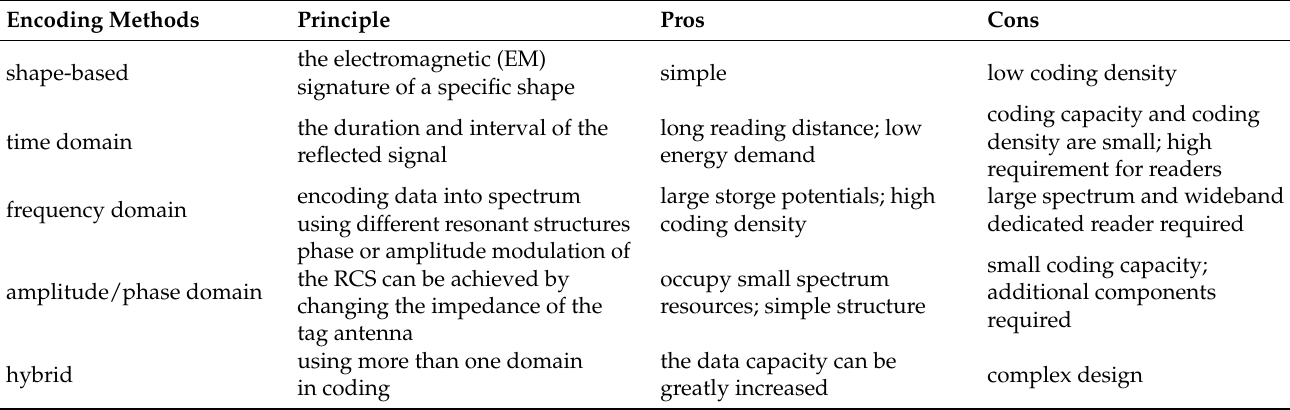
Table 6. The encoding techniques for chipless RFID.